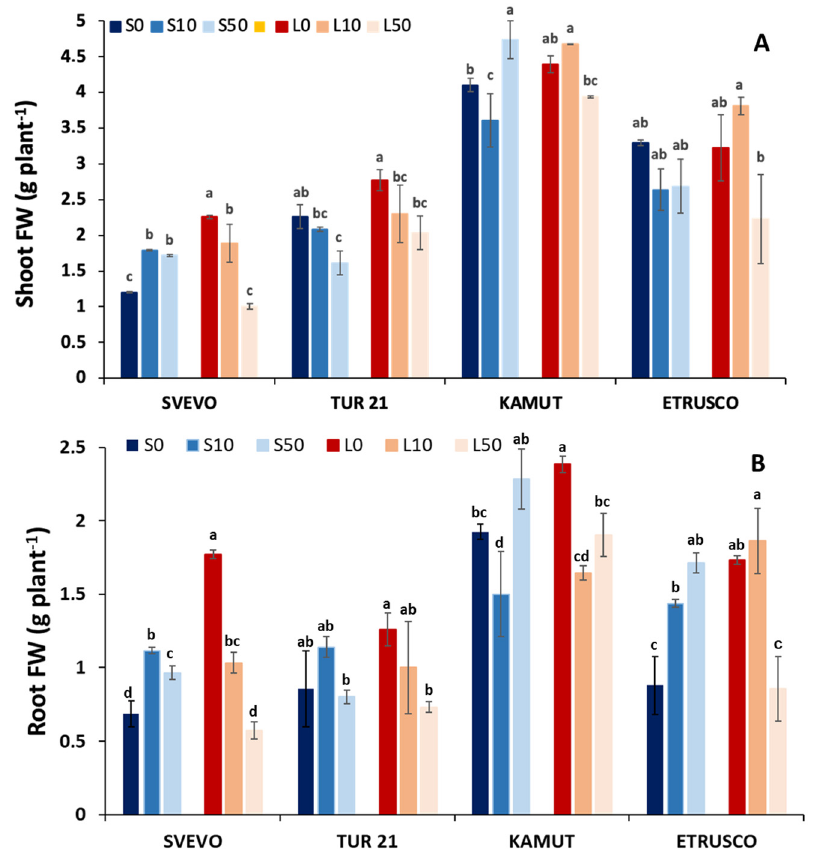
Figure 1. Plant growth parameters. Shoot ( A ) and root ( B ) fresh weight of four wheat genotypes (Svevo, Tur-21, Kamut, and Etrusco). Plants were grown while exposed to different sulfate levels (S and L, 1.2 and 0.06 mM sulfate, respectively) and three different Se levels (0, 10, and 50 µ M), provided as selenate. Data are means ± SD of four independent replications run in triplicate. Significant differences between samples are indicated by different letters ( p < 0.05).